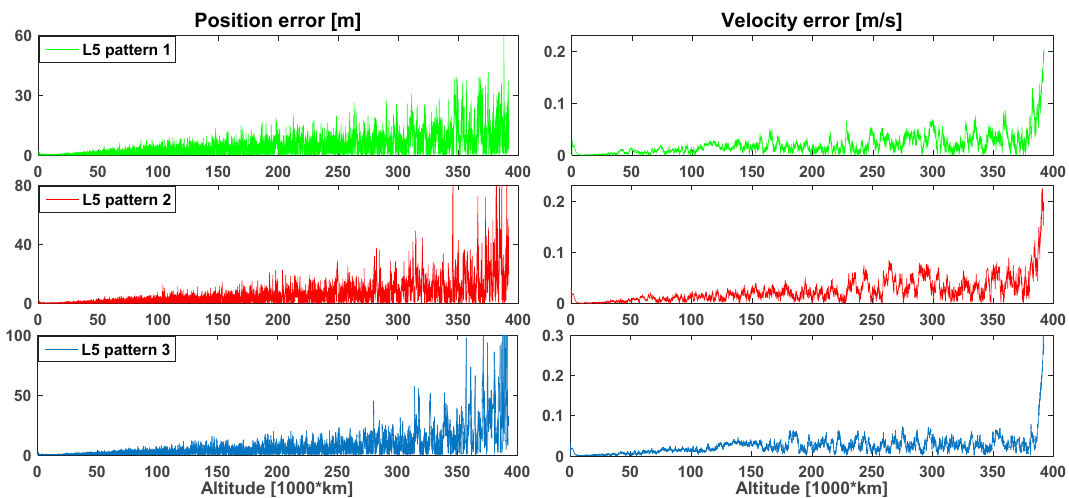
Figure 30. Range-based orbital filter estimation error for the assumed MTO.